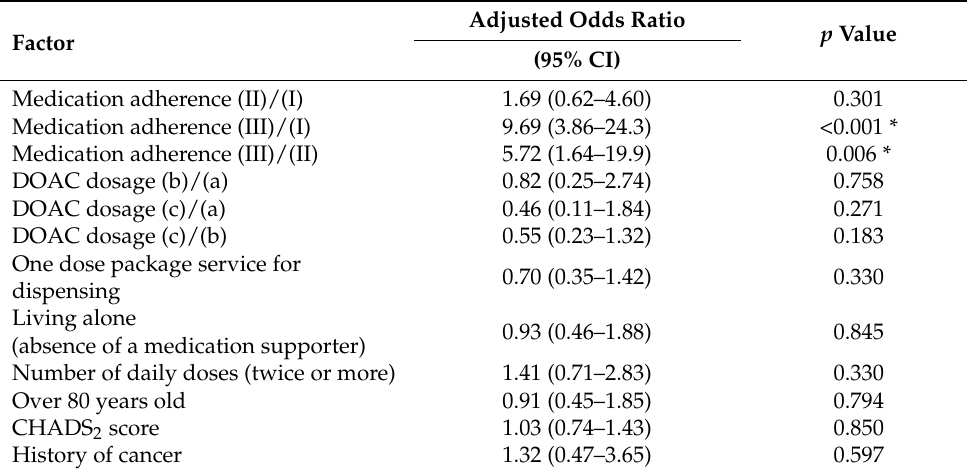
Table 4. Patients’ factors affecting hospitalization for cerebral